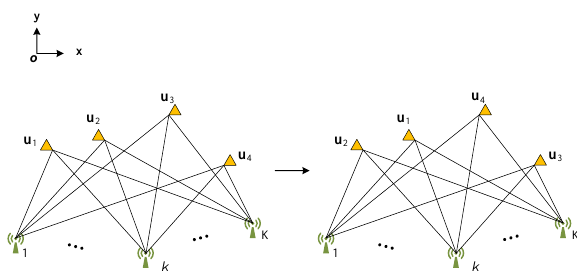
Figure 2. Example of array interchange.